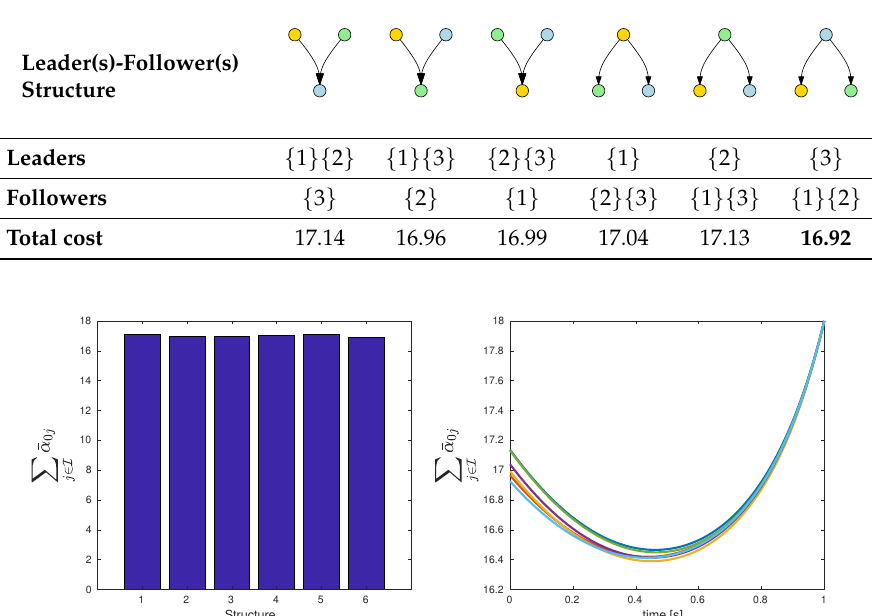
Figure 6. Evolution of the differential equations ˙¯ α leader/follower , and the corresponding initial values for the different number of leaders in the heterogeneous scenario. ) for the different number of leaders in the Table 2. Summary of ¯ α leader , ¯ α follower , and S ( |I L | , δ x 0 0 0 heterogeneous scenario. bold—significant difference.